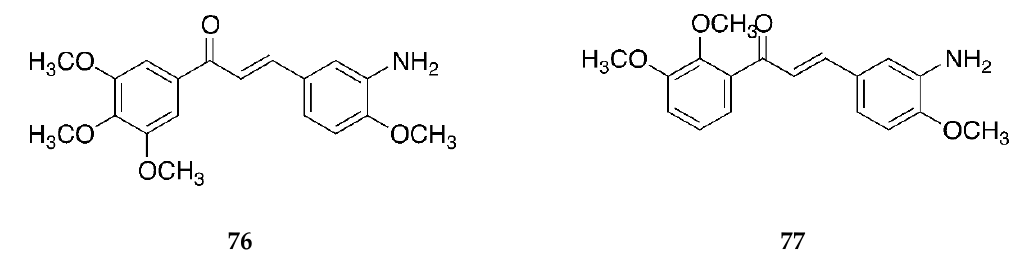
Figure 38. Chemical structures of the 3′-aminochalcone derivative with methoxy substitutions on ring A.